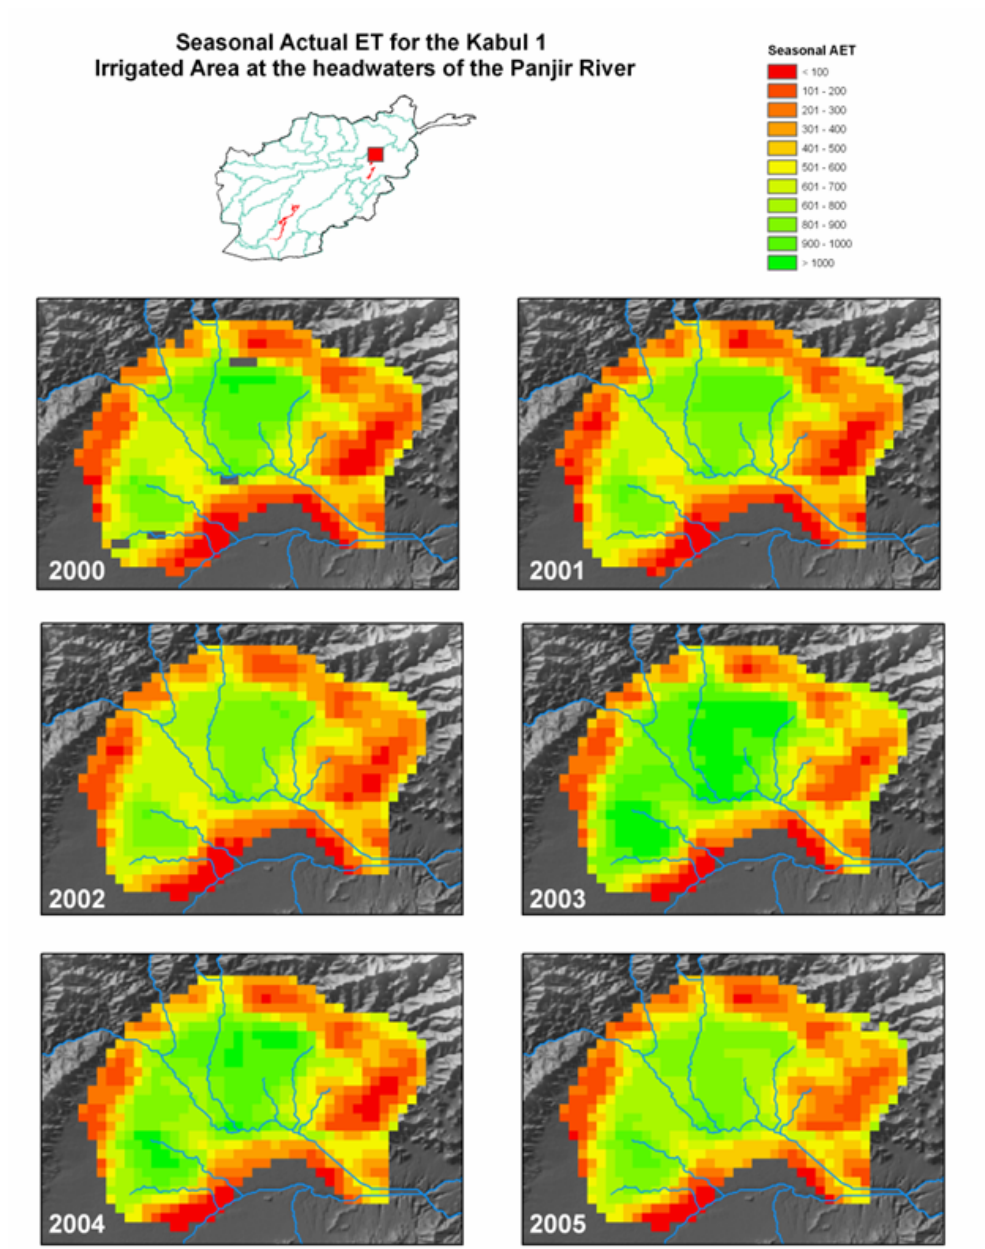
Figure 10. Seasonal (May – Sept.) actual ET (mm) distribution in irrigated fields of the Kabul 1 study